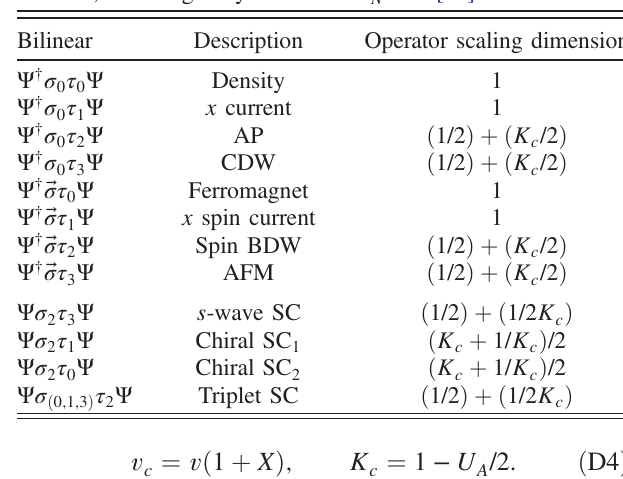
TABLE VII. Scaling dimensions of all fermion bilinears in the 1D limit ( ϵ ¼ 0 , n → ∞ ), in the stable gapless phase consisting of independent spin and charge Luttinger liquids; cf. Fig. 4(a). The common dimensions for the AP, CDW, spin-BDW, and AFM bilinears are the sum of the spin ( 1 /2) and charge ( K /2) sector c contributions; the same applies to the s -wave SC and triplet SC. The chiral SC 1 bilinears reside entirely in the charge sector. We ; 2 ignore logarithmic corrections to the spin sector attributable to < 0 nonzero, but marginally irrelevant U N